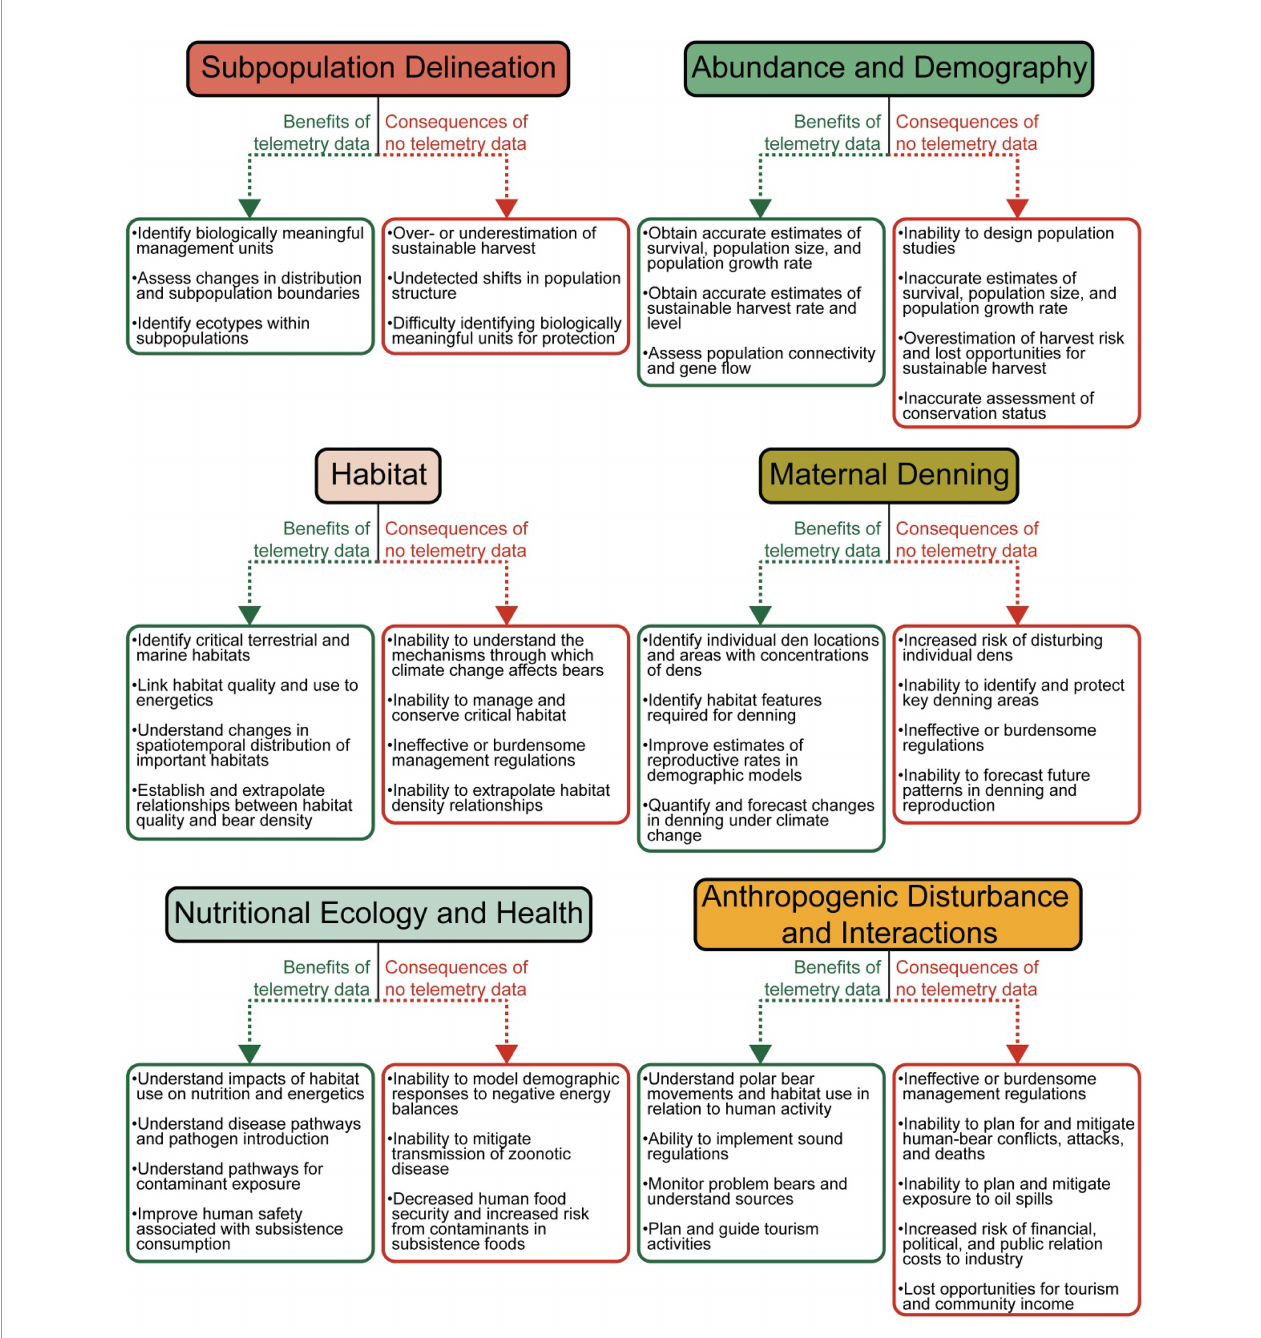
FIGURE 9 | Overview of the uses of satellite telemetry data for conservation and management of polar bears, together with the consequences of not having satellite telemetry